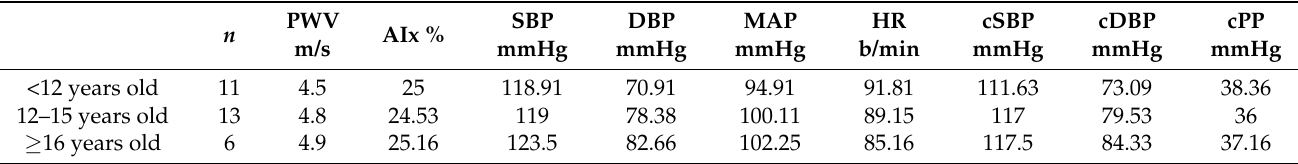
Table 6. Mean and Medians of PWA parameters for the obese subjects, by